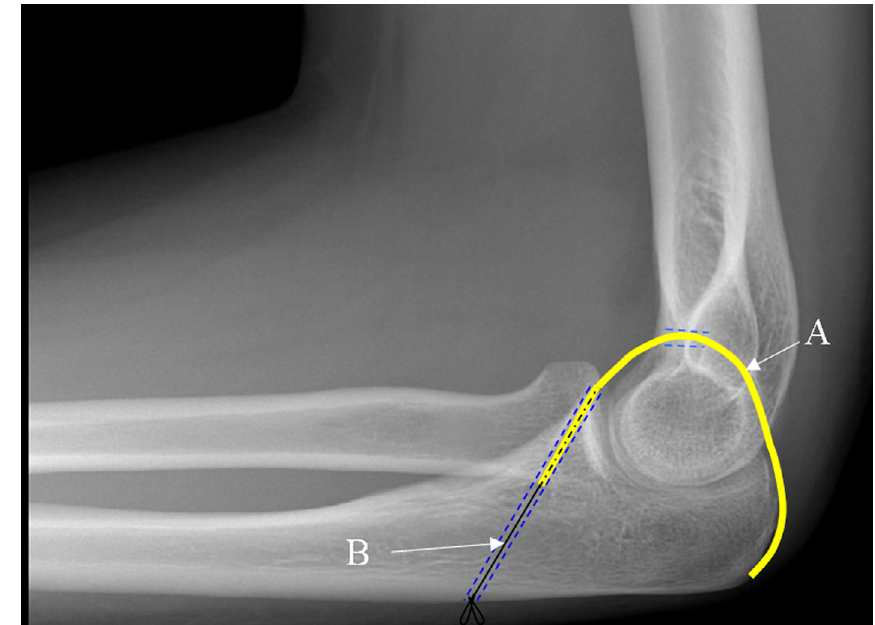
Figure 4. Diagram of triceps tendon (A) reconstruction and suture